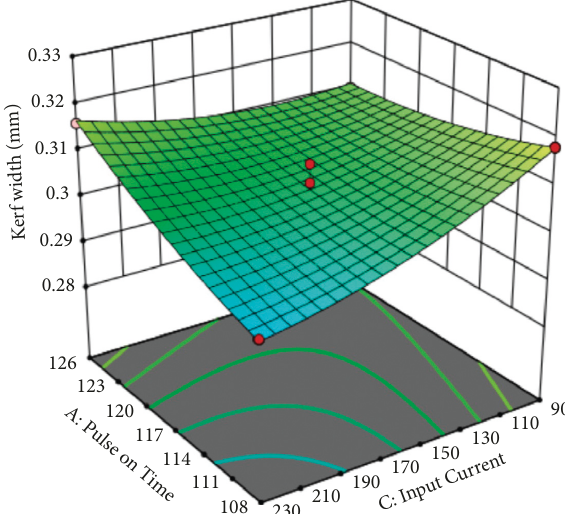
Figure 11: Joint performance on kerf width by T